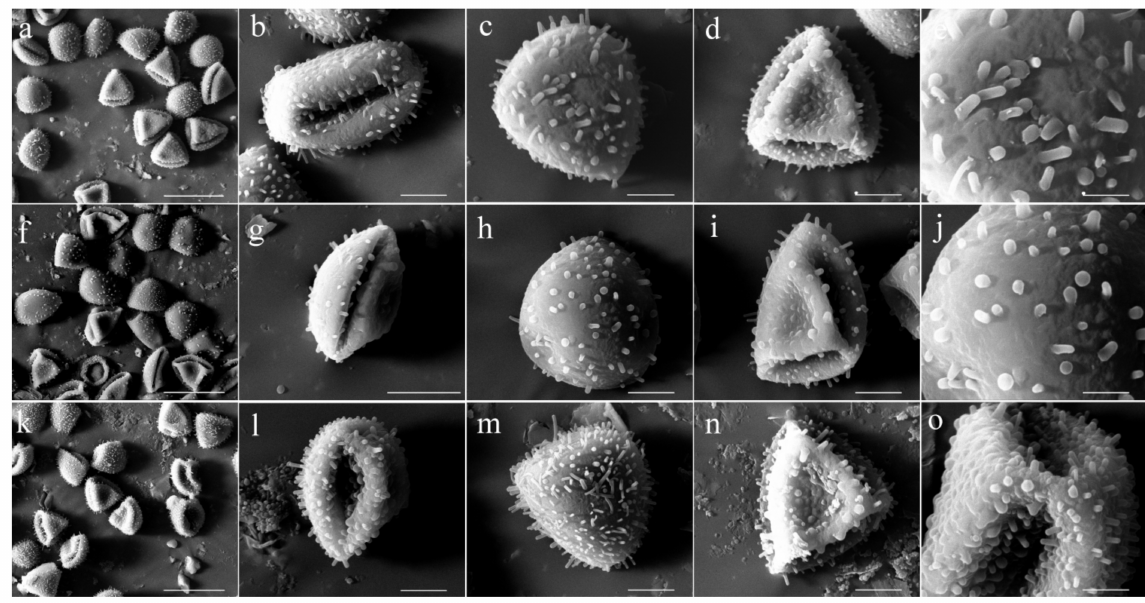
Figure 2. Microcosmic morphology of the pollen of three hardy water lilies. ( a – e ) N. ‘Rose Arey’. ( a ) Pollen population. Scanning electron microscope (SEM), bar = 50 µ m. ( b ) Equatorial view. SEM, bar = 10 µ m. ( c ) Distal polar view. SEM, bar = 10 µ m. ( d ) Proximal polar view. SEM, bar = 10 µ m. ( e ) Surface ornamentation. SEM, bar = 5 µ m. ( f – j ) N. ‘Perry’s Fire Opal’. ( f ) Pollen population. SEM, bar = 50 µ m. ( g ) Equatorial view. SEM, bar = 20 µ m. ( h ) Distal polar view. SEM, bar = 10 µ m. ( i ) Proximal polar view. SEM, bar = 10 µ m. ( j ) Surface ornamentation. SEM, bar = 5 µ m. ( k – o ) N. ‘Peter Slocum’. ( k ) Pollen population. SEM, bar = 50 µ m. ( l ) Equatorial view. SEM, bar = 10 µ m. ( m ) Distal polar view. SEM, bar = 10 µ m. ( n ) Proximal polar view. SEM, bar = 10 µ m. ( o ) Surface ornamentation. SEM, bar = 5 µ